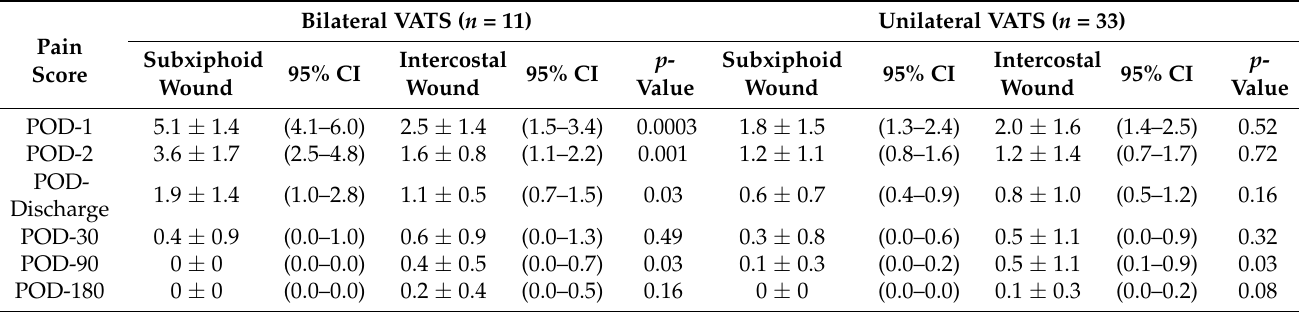
Table 4. Postoperative numerical rating scale (NRS) pain scores for patient subgroups.